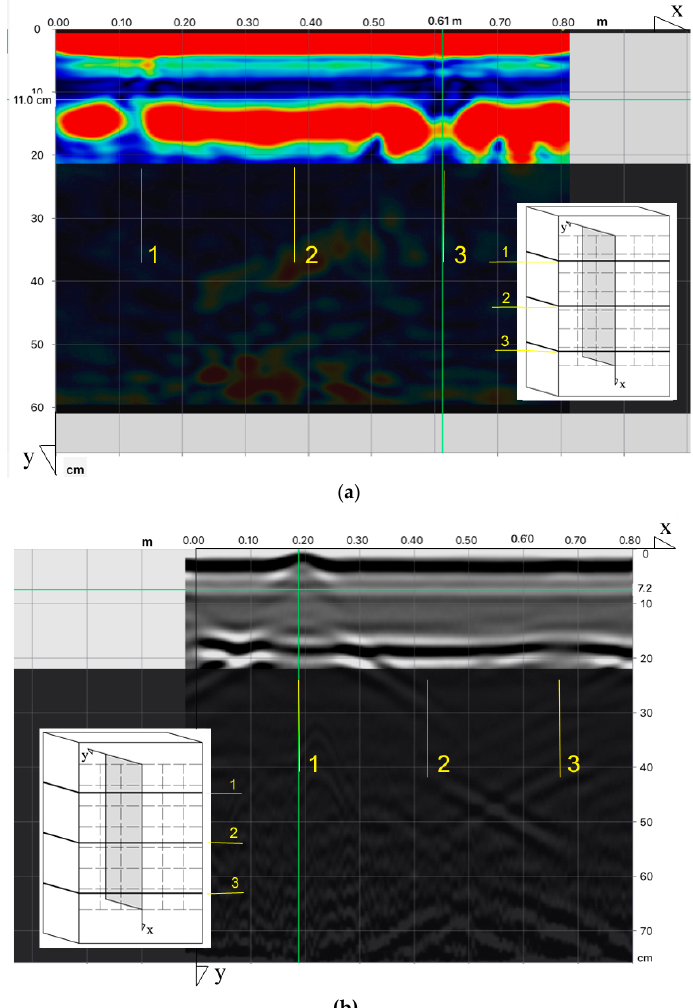
Figure 9. B-scans (sectional view of the element) of the masonry specimen No. 2 from tests performed with: ( a ) ultrasonic tomography, ( b ) GPR scanner, 1 —location of truss-type reinforcement, 2 —location of fibreglass mesh (size 5 × 5 mm), 3 —location of basalt mesh (size 8 × 8